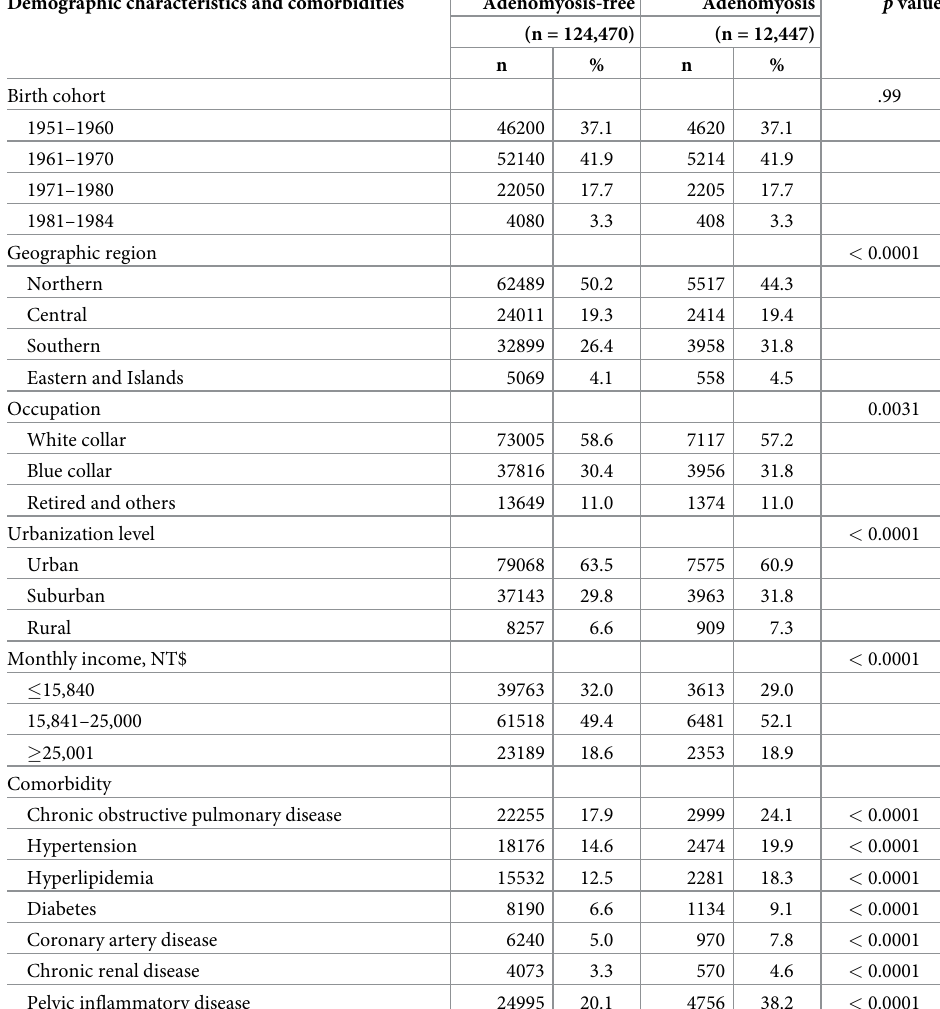
Table 2. Comparisons of demographic characteristics and comorbidities between adenomyosis and adenomyosis- free cohorts. Demographic characteristics and